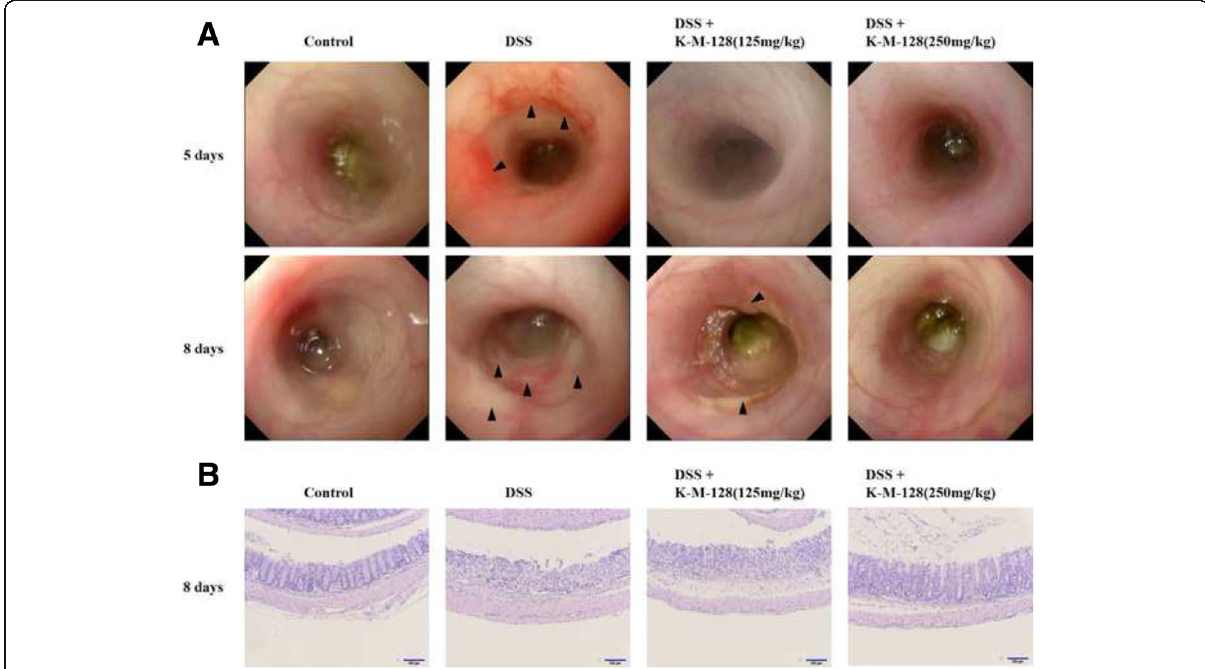
Fig. 2 The protective effect of KIOM-MA-128 against colitis in the intestinal crypts. We showed that our formula protected against DSS-induced mucosal damage, as shown by endoscopy ( a ) and hematoxylin & eosin staining ( b ). The arrow head indicates the lesion of